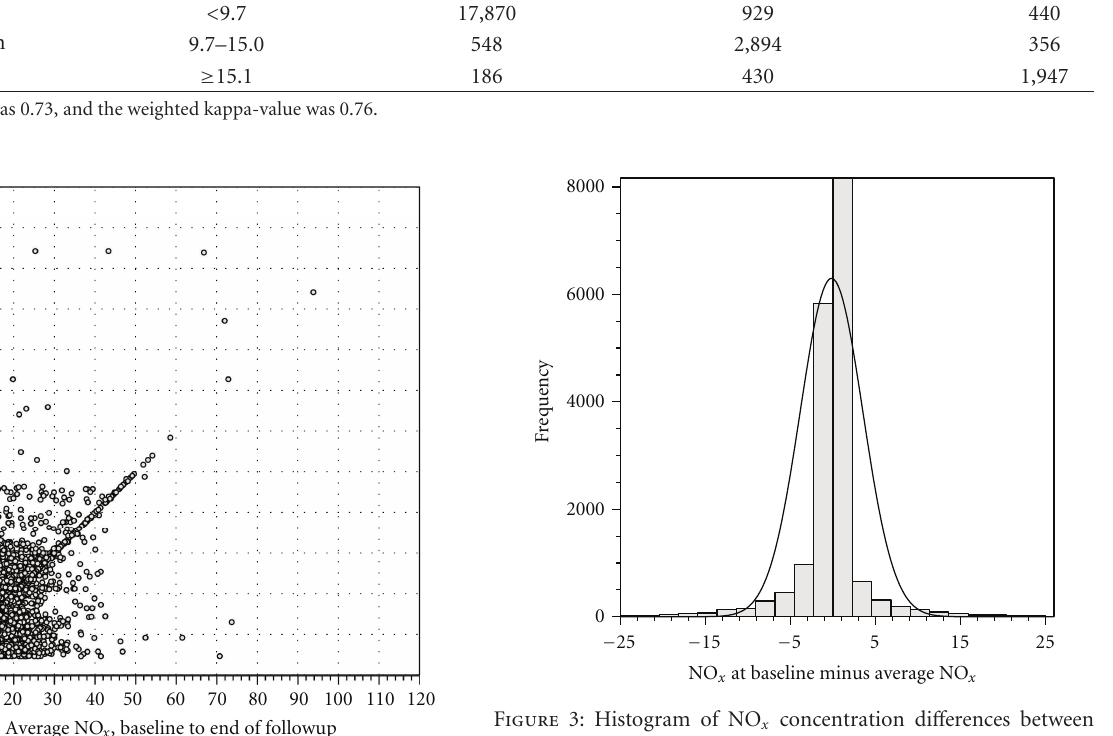
Figure 3: Histogram of NO x concentration di ff erences between inclusion and follow-up average concentrations. The highest bar represents those with a 0 or very small di ff erence ( n = 15,962) and has been